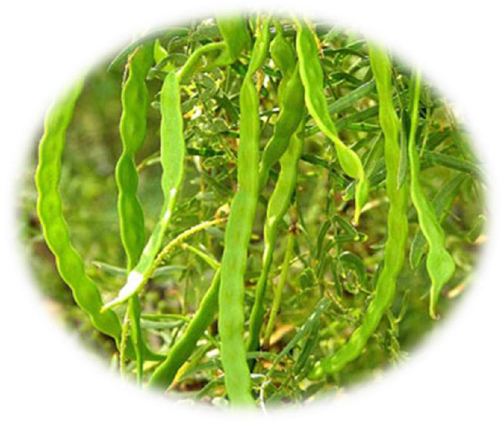
Fig. 20 mesquite seed gum as